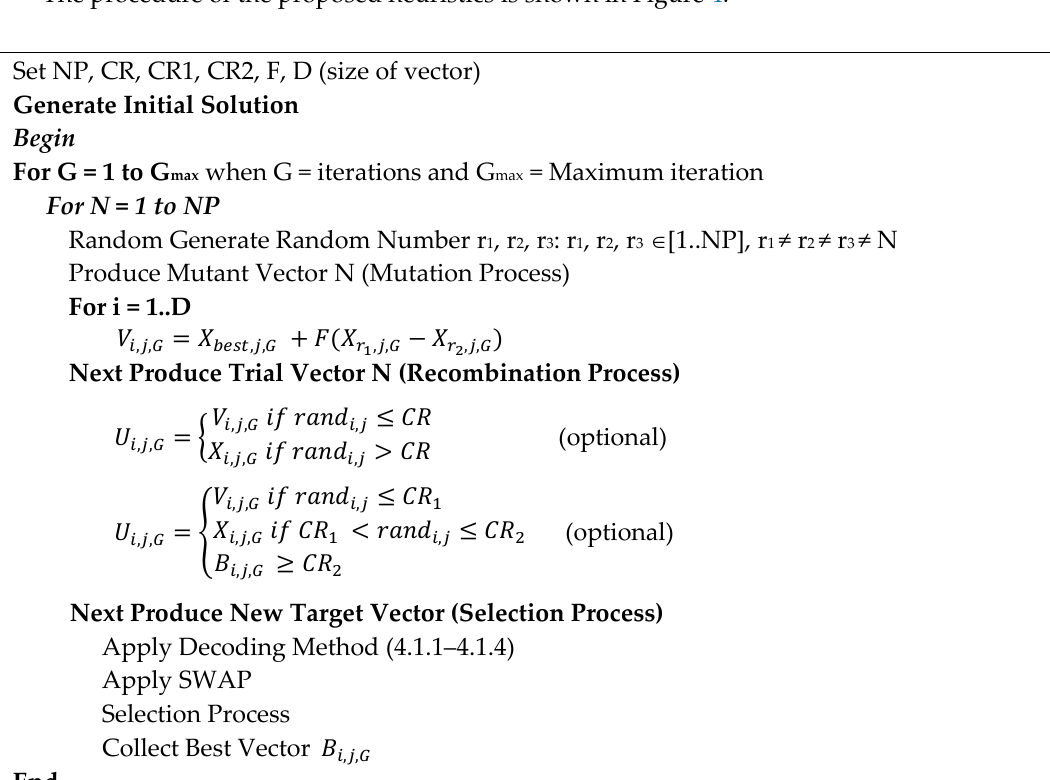
Table 13. Parameter setting of test instances.